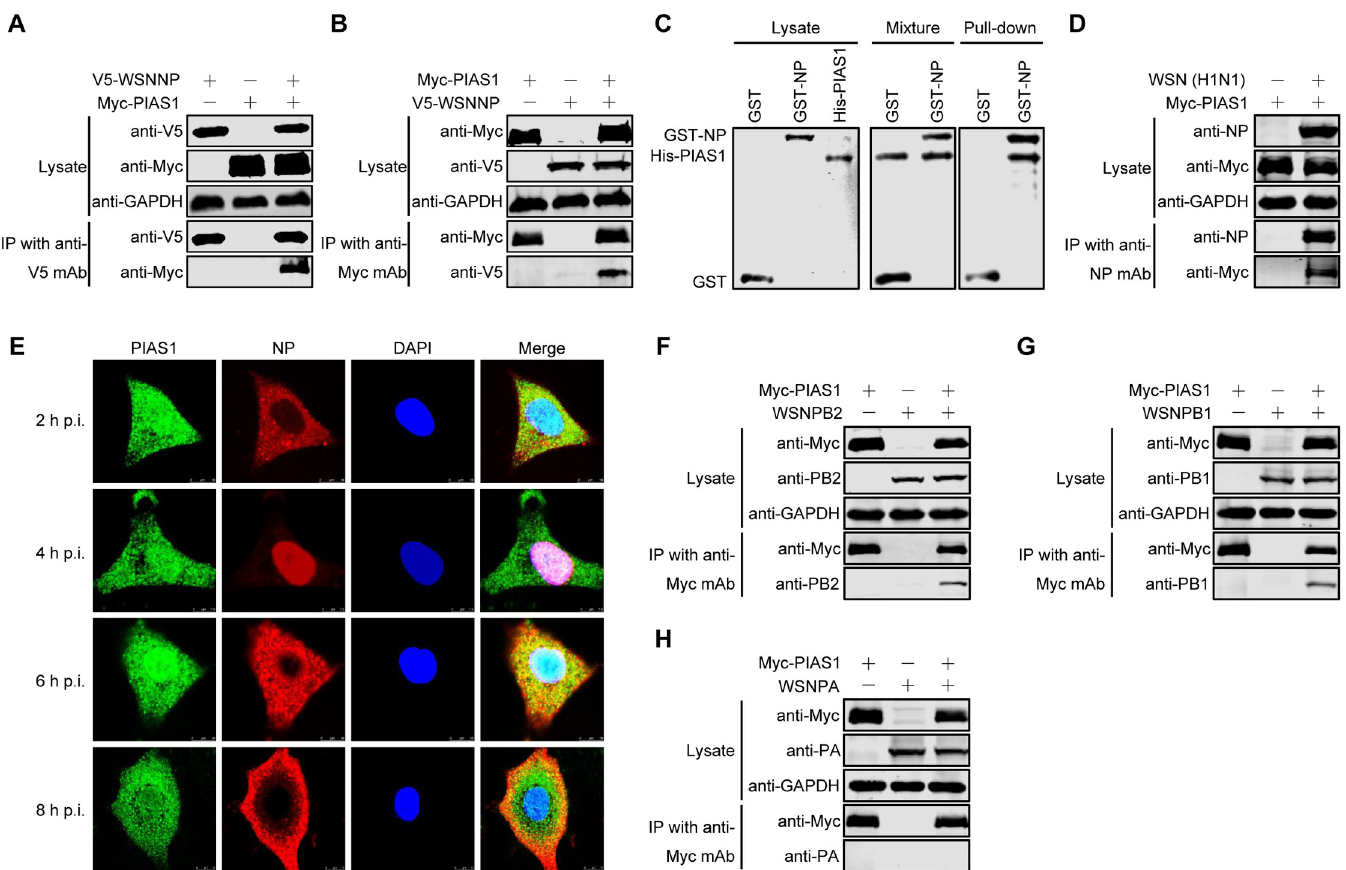
Fig 1. PIAS1 interacts with multiple proteins in the RNP complex of IAV. (A, B) Interaction of V5-WSNNP and Myc-PIAS1 in HEK293T cells by using a co-IP assay. HEK293T cells were individually transfected or co-transfected with plasmids expressing V5-WSNNP and Myc-PIAS1. Cell lysates were immunoprecipitated with a mouse anti-V5 mAb (A) or a mouse anti-Myc mAb (B), and subjected to western blotting with a rabbit anti-V5 pAb and a rabbit anti-Myc pAb for the detection of WSNNP and PIAS1, respectively. (C) Interaction of GST-WSNNP and His-PIAS1 by using a GST pull-down assay. His-tagged PIAS1 was expressed in E . coli BL21 (DE3) and purified by using Ni Sepharose Excel resin, and the GST or GST-NP protein was expressed in HEK293T cells and purified by using Glutathione Sepharose 4 Fast Flow. An equal amount of purified PIAS1 was mixed with the Glutathione Sepharose 4 Fast Flow samples that bind GST or GST-NP. After rocking and washing, the mixed samples were separated by SDS-PAGE and stained with Coomassie blue. (D) Interaction of IAV NP and PIAS1 in virus-infected cells. HEK293T cells were transfected for 24 h to express Myc-PIAS1, and were then infected with WSN (H1N1) virus (MOI = 5). At 30 h p.i., cell lysates were immunoprecipitated with a mouse anti-NP mAb, followed by western blotting with a rabbit anti-NP pAb and a rabbit anti-Myc pAb. (E) Co-localization of IAV NP and PIAS1 in A549 cells infected with WSN (H1N1) virus. A549 cells were infected with WSN (H1N1) virus (MOI = 5). At 2, 4, 6, and 8 h p.i., the infected cells were fixed and stained with a mouse anti-NP mAb and a rabbit anti-PIAS1 pAb, followed by incubation with Alexa Fluor 633 goat anti-mouse IgG (H+L) (red) and Alexa Fluor 488 donkey anti-rabbit IgG (H+L) (green). The nuclei were stained with DAPI. (F-H) Co-IP assay to examine the interactions between Myc-PIAS1 and PB2, PB1, and PA of WSN (H1N1) virus in HEK293T cells. HEK293T cells were individually transfected or co-transfected with plasmids expressing WSNPB2, WSNPB1, WSNPA, and Myc-PIAS1. Cell lysates were immunoprecipitated with a mouse anti-Myc mAb and were subjected to western blotting with a rabbit anti-PB2 pAb (F), a rabbit anti-PB1 pAb (G), a rabbit anti-PA pAb (H), and a rabbit anti-Myc pAb (F-H) for the detection of PB2, PB1, PA, and PIAS1,